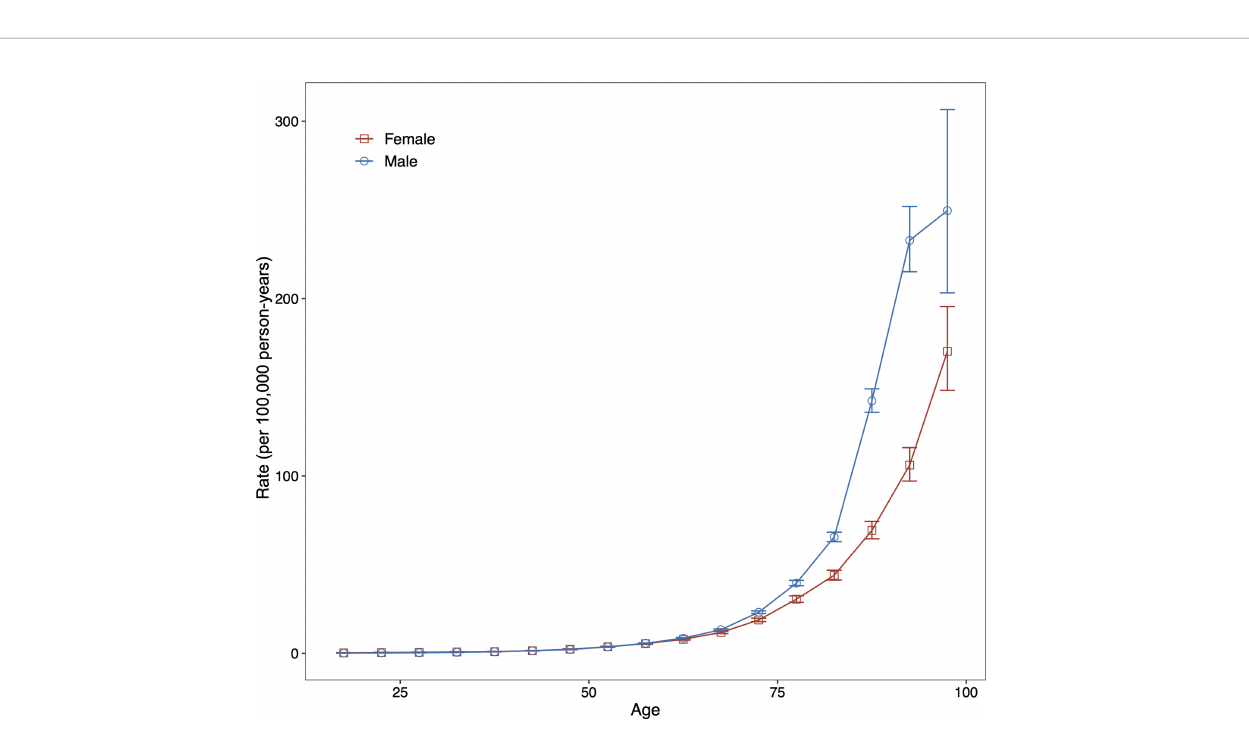
FIGURE 3 | Fitted longitudinal age curves of type 2 diabetic kidney disease (DKD) mortality (per 100,000 person-years) and the corresponding 95% con fi dence interval for males and females. DKD, type 2 diabetic kidney